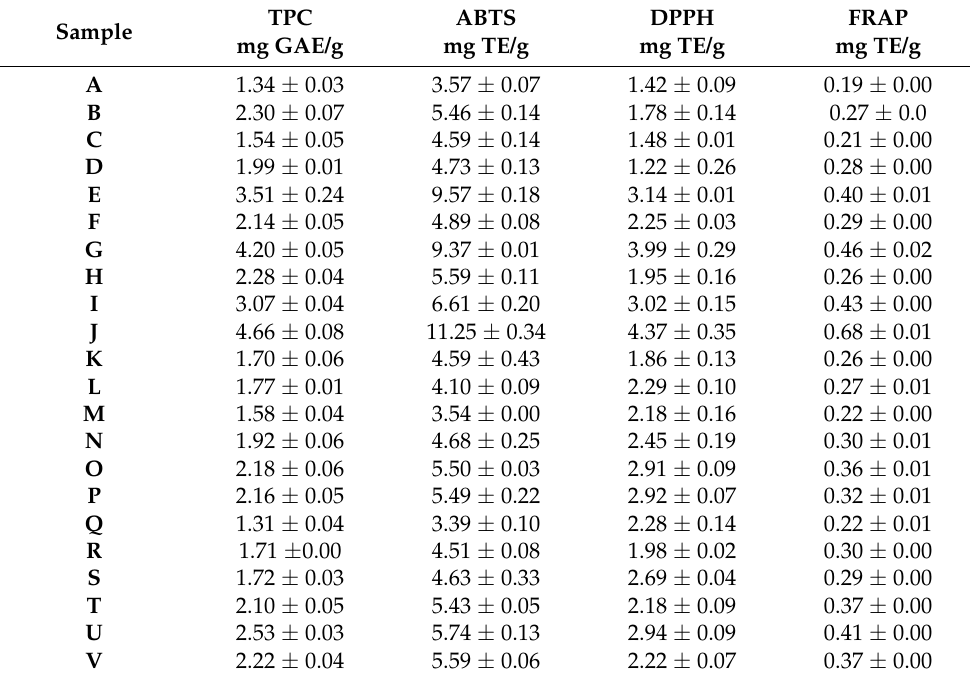
Table 3. TPC and antioxidant activity (ABTS, DPPH, and FRAP) values of hazelnut shell extracts (mean values ±